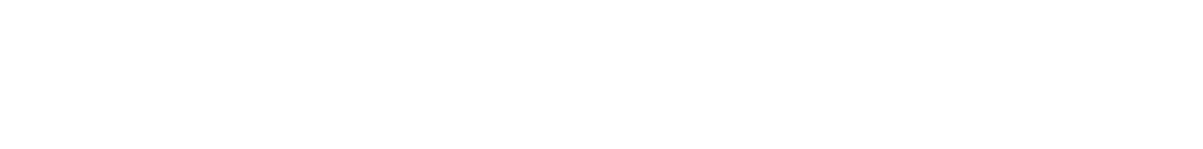
Frontiers in Communication |